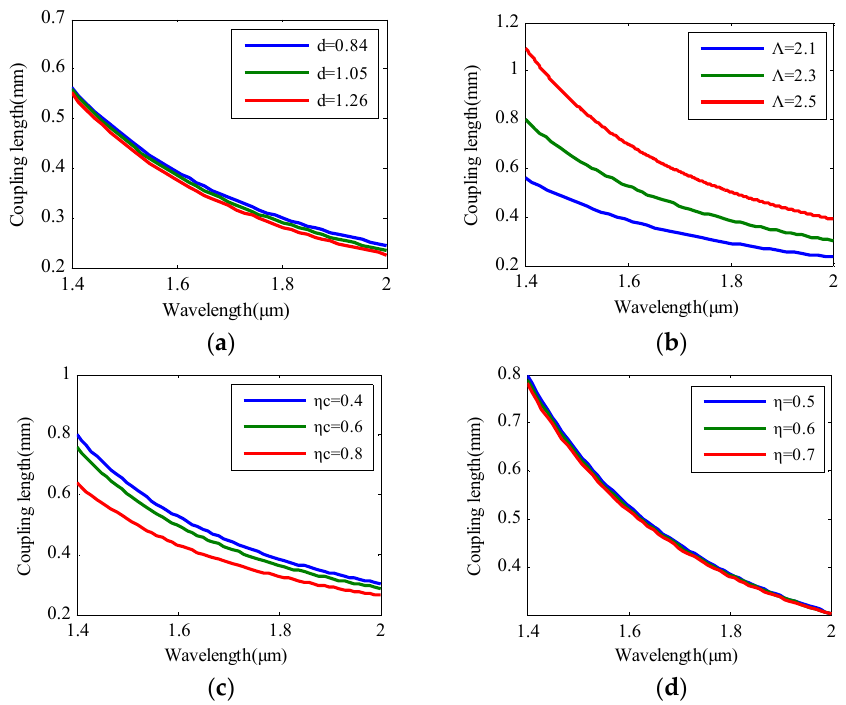
Figure 5. Coupling length of x-polarized input light with varying structure parameters. ( a ) Coupling length with different d/ Λ , ( b ) coupling length with different Λ , ( c ) coupling length with different η c, and ( d ) coupling length with different η .